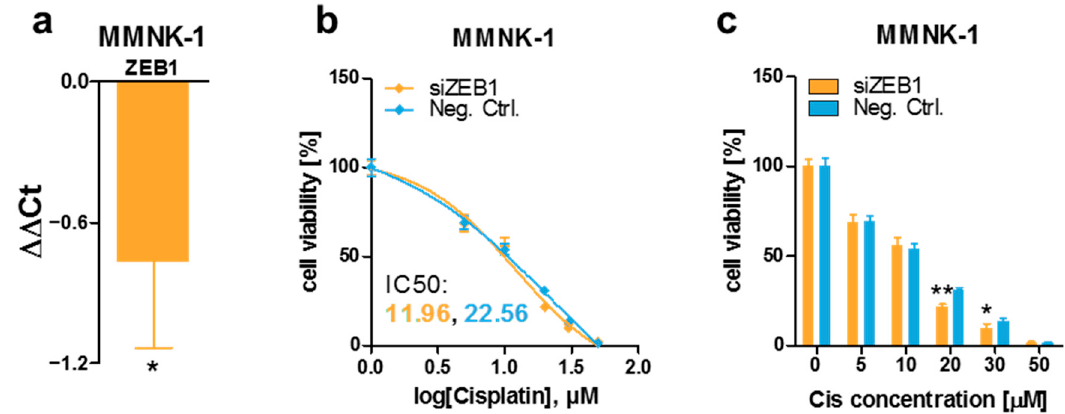
Figure 5. Transient ZEB1 knockdown leads to a decreased cisplatin resistance in MMNK-1 cells. ( a ) MMNK-1 cells were transfected with 50 nM ZEB1 siRNA (siZEB1) or Allstars Neg. Ctrl. (Neg. Ctrl.), and the ZEB1 expression level was compared via the ∆∆ Ct method. A negative value represents a downregulation; a value of 0 indicates that there was no difference between siZEB1-transfected cells and Neg. Ctrl.-transfected cells. Unpaired two-tailed t-test was used to evaluate statistical significance. ( b ) IC50 determination via ordinary least-squares regression with outlier removal following the ROUT method and ( c ) direct comparison of transient ZEB1 knockdown and control conditions in MMNK-1 cells. Cells were transfected with 50 nM ZEB1 siRNA (siZEB1) or AllStars Neg. Ctrl. (Neg. Ctrl.) and subsequently treated with various concentrations of cisplatin (Cis). After 48 h, cell viability was assessed by adding WST-1 reagent and measuring absorbance at 450 nm and 620 nm (reference wavelength). Cells treated with cisplatin were normalized to untreated (0 μ M) cells (set to 100%). Unpaired two-tailed t-test was used to evaluate statistical significance. * p < 0.05, ** p < 0.01.